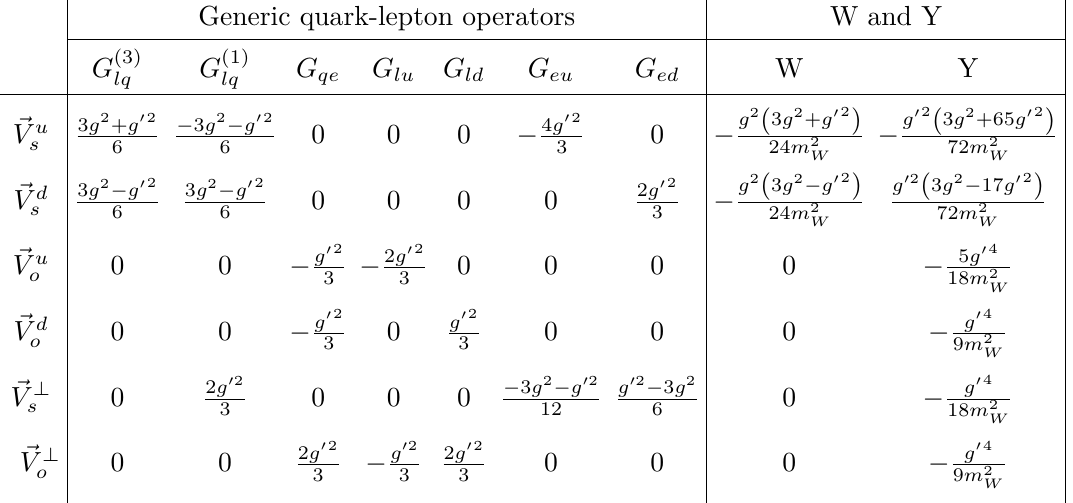
and ~V ⊥ vectors. The first part of the s,o s,o